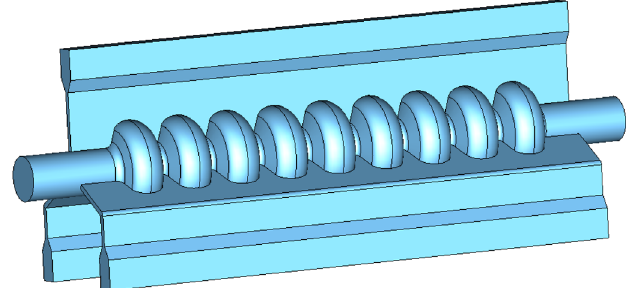
FIG. 9. (Color) Nine-cell slotted cavity model used in MWS simulation. The waveguide was bent parallel to the boundary for simulation.